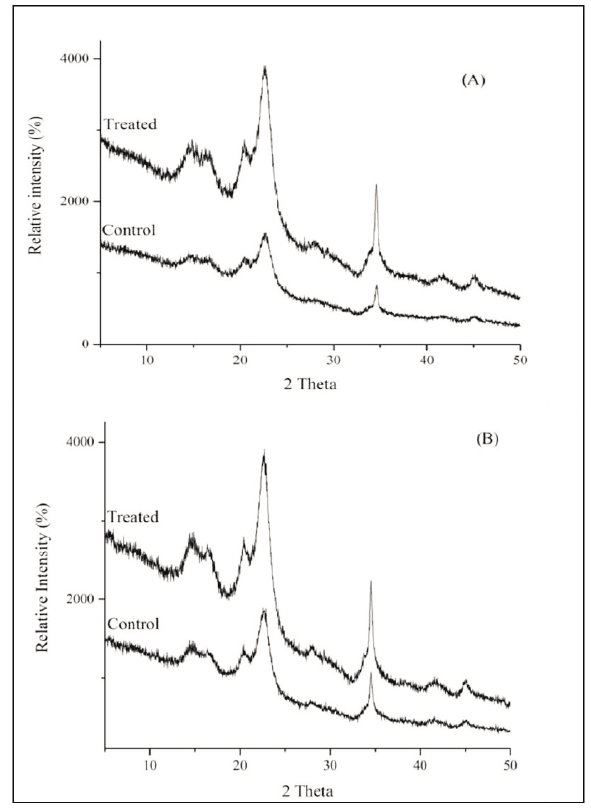
Fig. 5 - X-ray powder diffraction patterns of fibers in control and treated Aleppo 118 and Deir Al-Zour 22